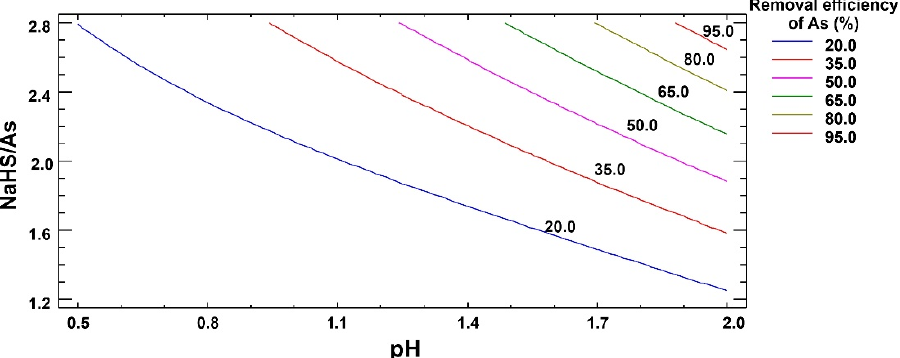
Figure 4. Dependence of the removal efficiency of arsenic (III) sulphide on pH and molar ratio of NaHS/As (contour response surface).